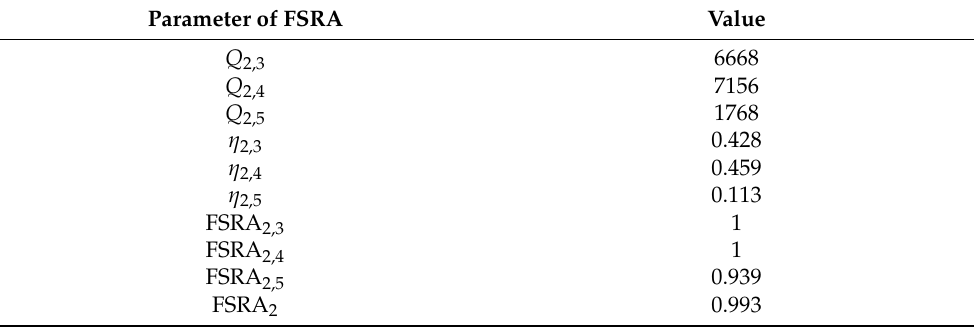
Table 4. FSRA calculation results in the altitude range of 8900–12,500